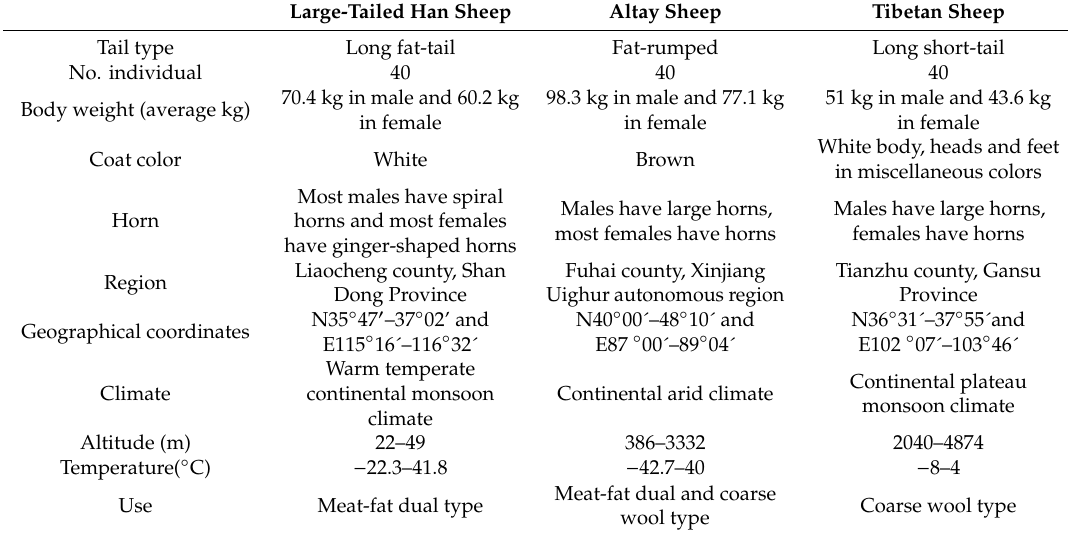
Table 1. Description of phenotypic characteristics and environmental variables of three sheep breeds sampled in this